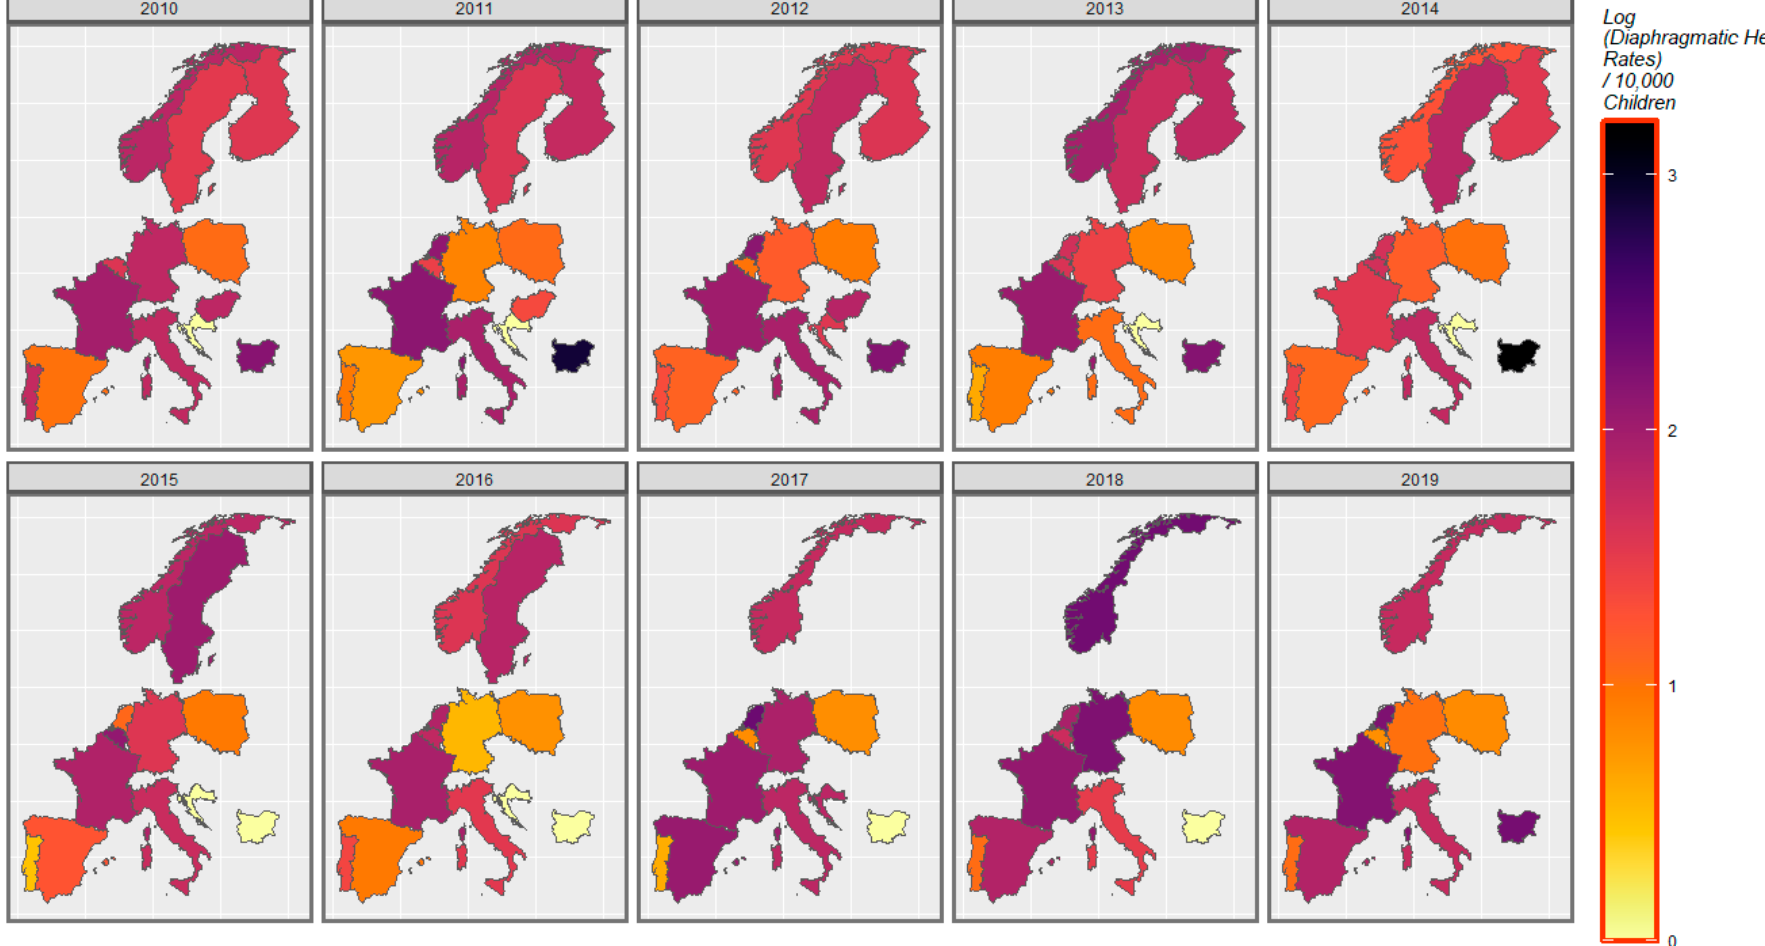
Figure 6. Sequential map-graph of diaphragmatic hernia across selected European nations for each year of 2010–2019.